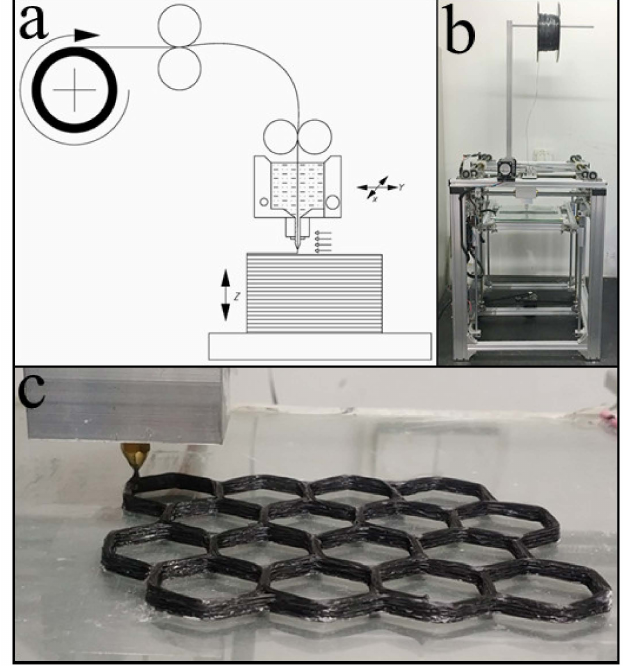
Figure 4. Working process of the printing module: ( a ) a schematic illustration of the printing process, ( b ) printing equipment, and ( c ) the working process of the printing